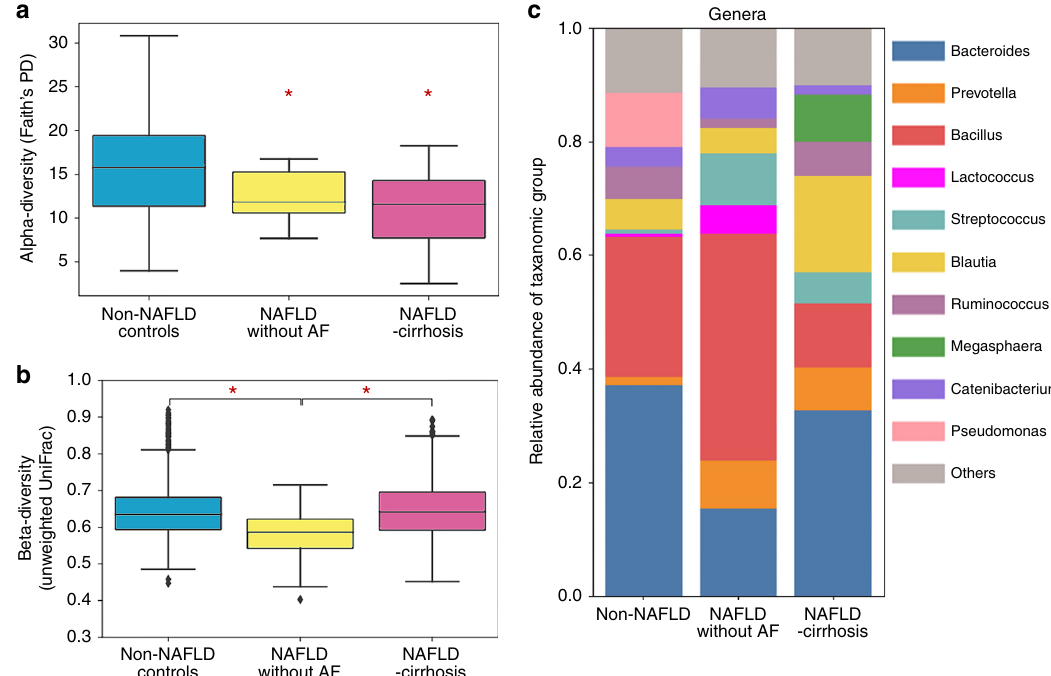
Fig. 2 Gut microbiome alteration in NAFLD-cirrhosis. Comparison between non-NAFLD controls in blue ( n = 51), NAFLD without advanced fi brosis in yellow ( n = 17), and NAFLD-cirrhosis probands in pink ( n = 25) with respect to a alpha-diversity using Faith ’ s Phylogenetic Diversity. Non-NAFLD controls have signi fi cantly higher alpha-diversity compared to probands with NAFLD without AF in yellow ( p = 0.0163) and NAFLD-cirrhosis in pink ( p = 0.0020). b Similar plot for beta-diversity using unweighted UniFrac distance metric. The beta-diversity among probands with NAFLD without AF in yellow was signi fi cantly lower than that among non-NAFLD controls in blue ( p = 1.14E-18) and probands with NAFLD-cirrhosis in pink ( p = 3.32E-15). The box plots show the quartiles and whiskers show the rest of the distribution (1.5 inter-quartile range) the center liner corresponds to the median. c Gut microbiome composition of non-NAFLD controls, NAFLD without AF and NALFD-cirrhosis probands shows differences at bacterial genus level. All p value were determined by two-sided Kruskal-Wallis test. * p value < 0.05. Source data are provided as a Source Data fi